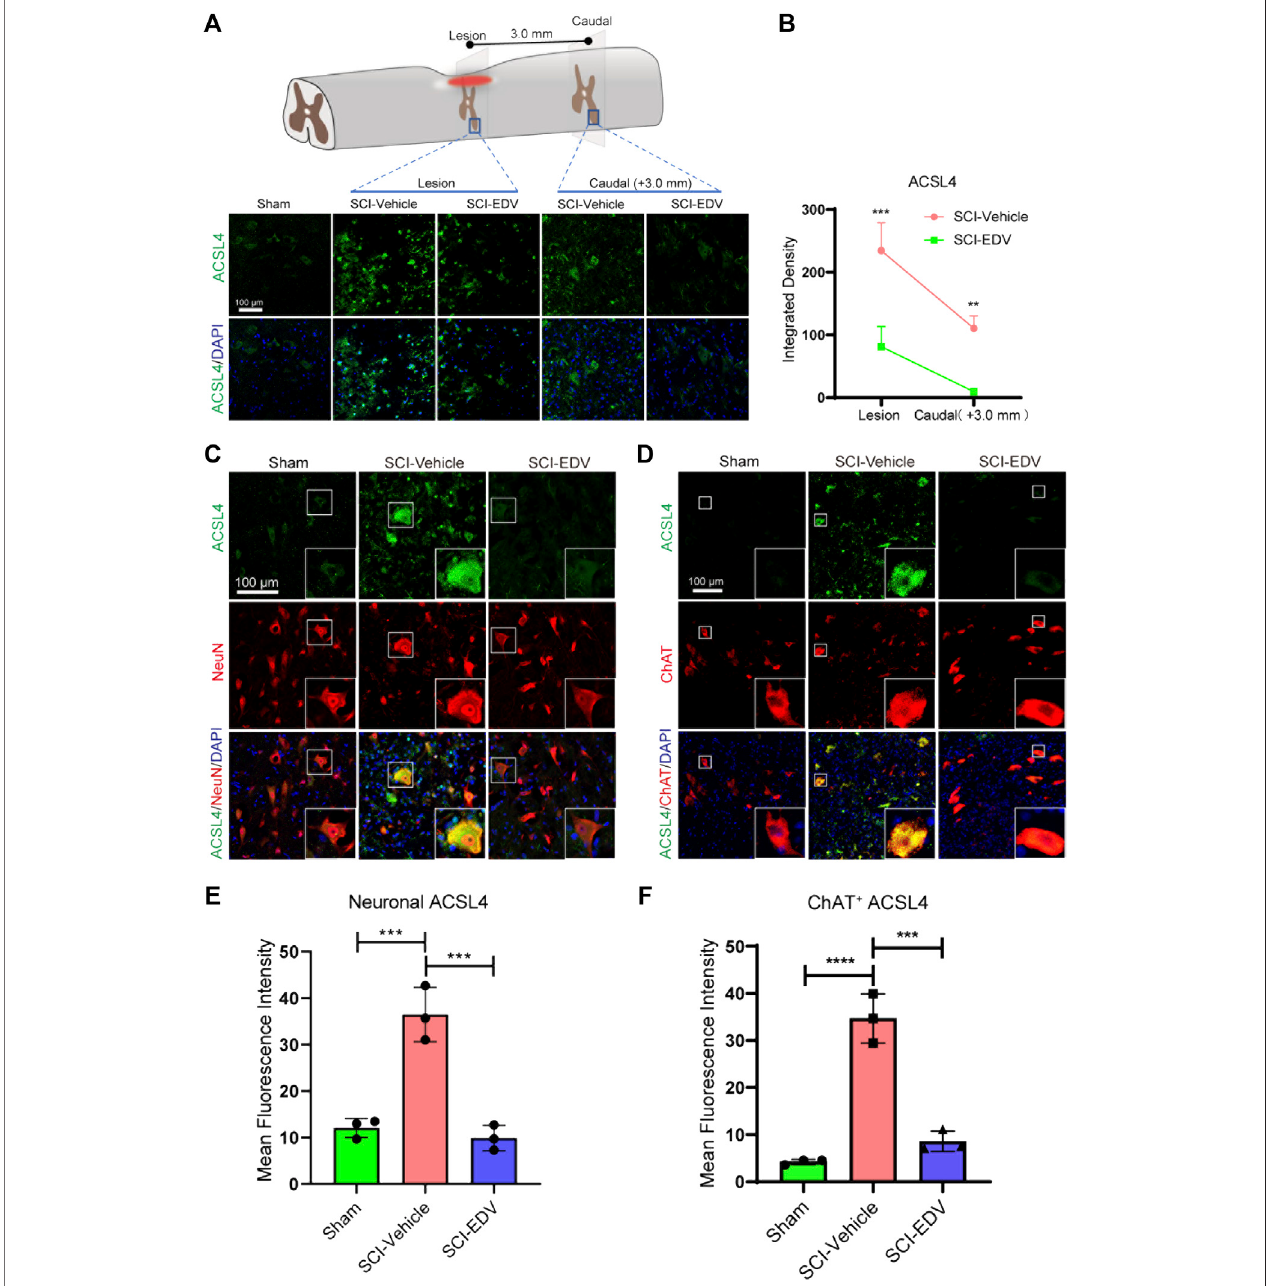
FIGURE 3 | Edaravone downregulates ACSL4 at 2 days post SCI. (A) Upper, schematic diagram of ACSL4 detected injured epicenter and caudal spinal cord ventral horn(3 mm tothe lesion) at 2 days postSCI. Lower, immuno fl uorescence images ofACSL4 (green) inthe lesion epicenterand caudalspinal cord section. Nuclei werestained with DAPI(blue).Scalebar,100 μ m. (B) Quanti fi cation of theACSL4intensity inthe lesion and caudalsegment. (C,D) Representative immuno fl uorescence images of of ACSL4 (green)/NeuN (red) (C) and ACSL4 (green)/ChAT (red) (D) in the caudal spinal cord at 3.0 mm to the lesion at 2 days post SCI. Scale bar,100 μ m. (E,F) Quanti fi cation of neuronal (NeuN positive) ACSL4 (E) and motor neuronal (ChAT positive) ACSL4 (F) . Data are expressed as mean ± standard deviation.Statisticalsigni fi cancewasdeterminedbytwo-wayANOVAwithSidak ’ smultiplecomparisonstest (B) orone-wayANOVAwithTukey ’ sposthoctest (E,F) .* p < 0.05, ** p < 0.01, and *** p < 0.001, n = 3, bar = 100 μ m.